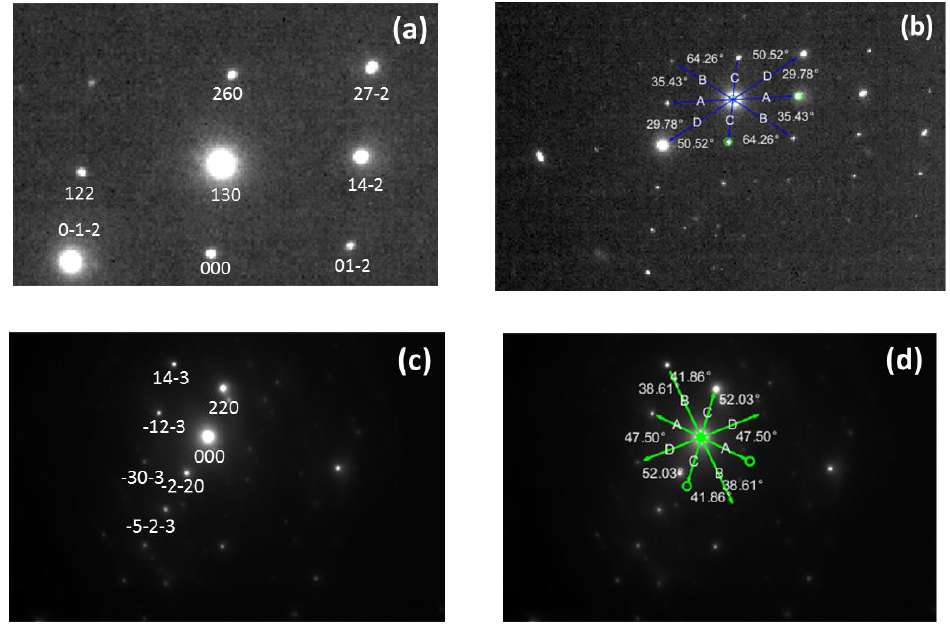
Figure 8. Indexed pattern of Figure 7 ( a ) chromium carbide of the type Cr 7 C 3 , ( b ) detected vectors of Cr7C3, ( c ) chromium-enriched cementite, ( d ) detected vectors of cementite.